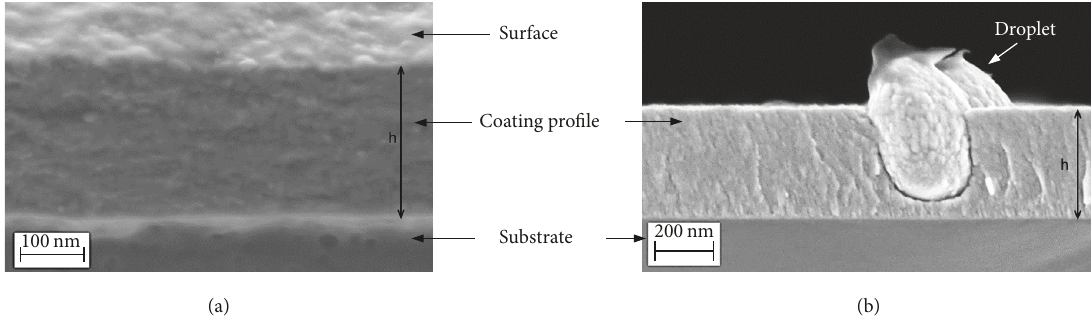
Figure 7: Cross-sectional SEM images of AlTiN coatings deposited at 100Hz on 100Cr6-steel substrate (a) and silicon substrate (b) with film thickness ℎ = 0.366 𝜇 m.